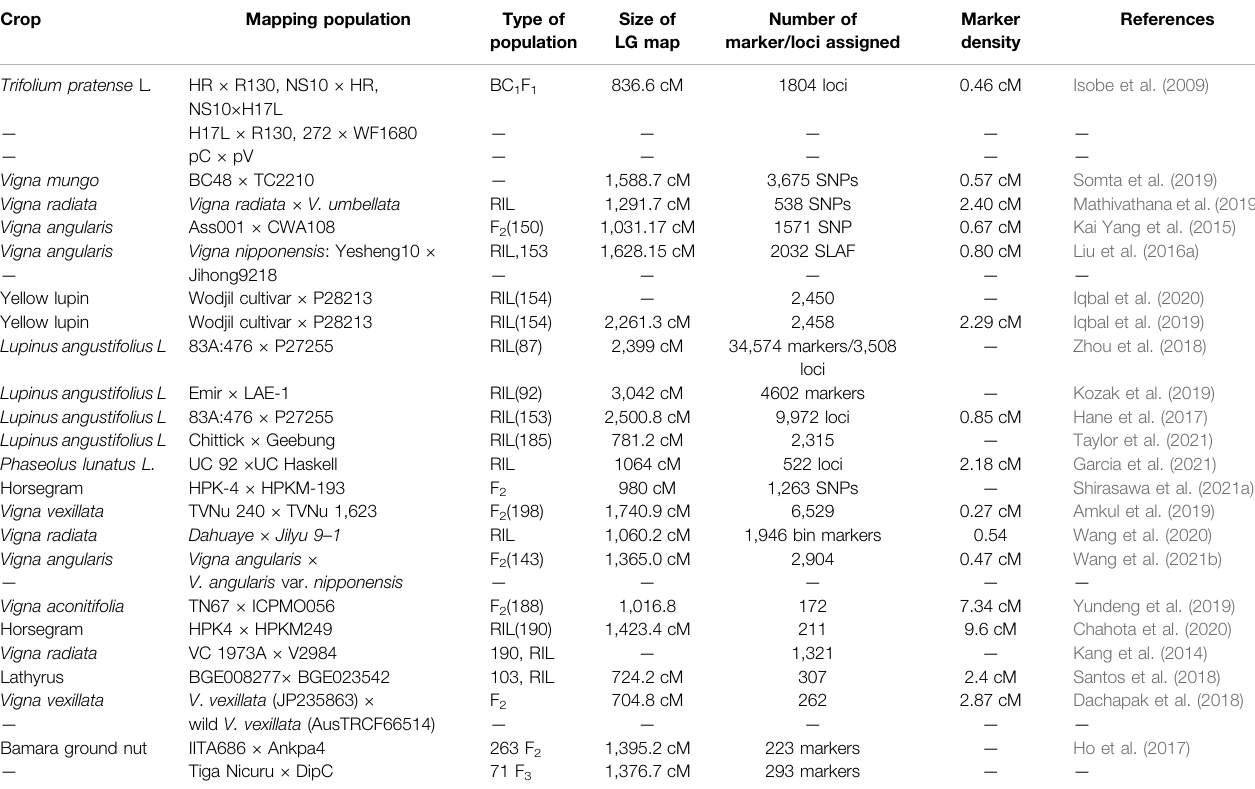
Size of Number of population LG map marker/loci assigned